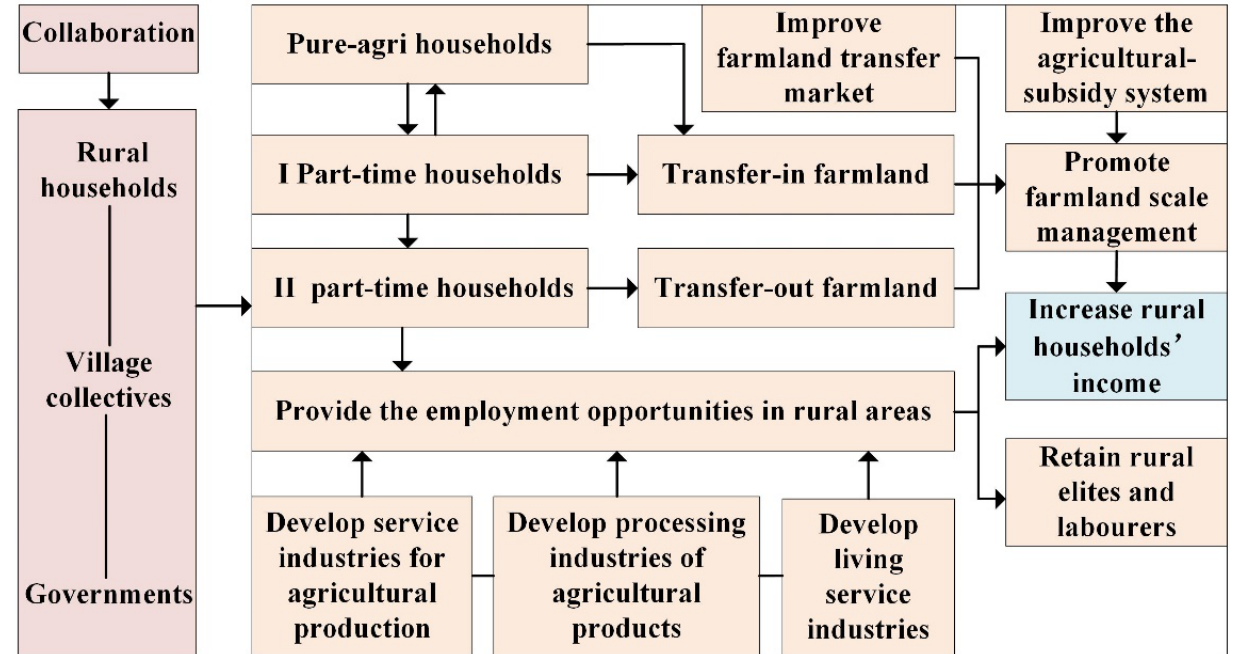
Figure 3. The paths to increase rural households’ income.